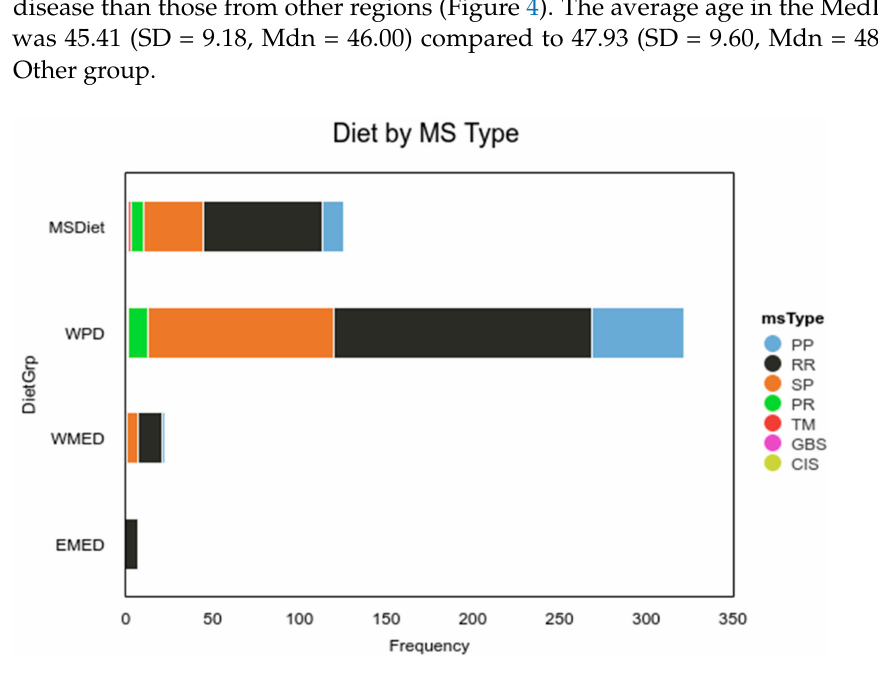
Figure 4. Diet by MS type. Note. MS Diet = MSDiet, Western Pattern Diet = WPD, Western Mediter- ranean =WPD, and Eastern Mediterranean Diet = EMED. EDSS categories: PPMS = Primary Progres- sive, SPMS = Secondary Progressive, RRMS= Relapsing-Remitting, PRMS = Progressive Relapsing, TM = Transverse Myelitis, GBS = Guillain-Barre Syndrome, CIS=Clinically Isolated